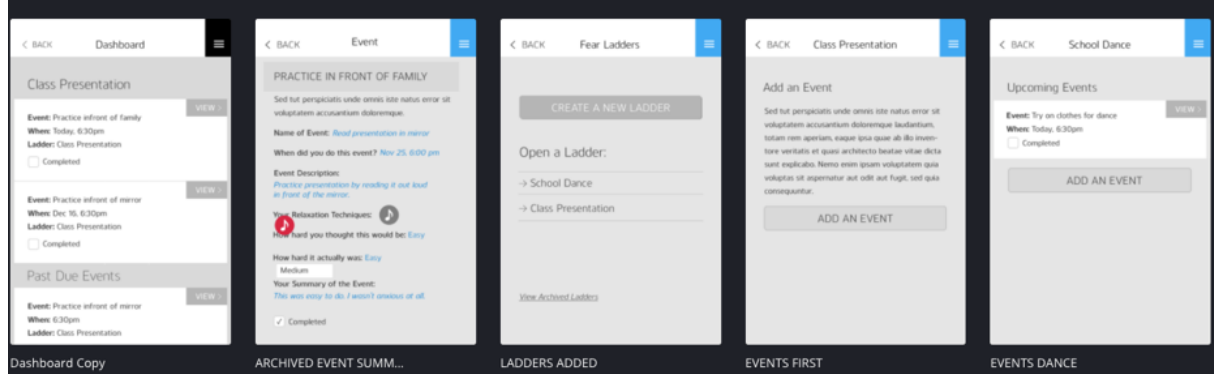
Figure 3. A screenshot of several phone screens for the predesign prototype of the MindClimb app.